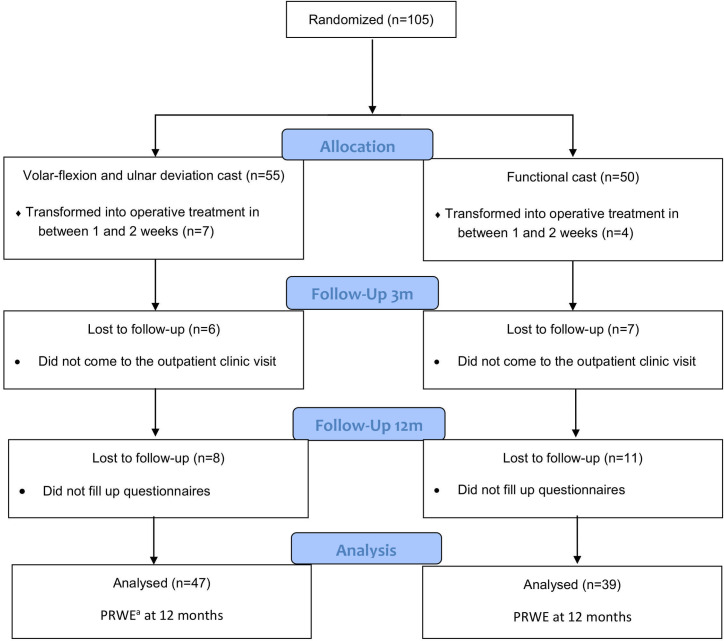
The flow diagram of the study (CONSORT).aPRWE = patient-rated wrist evaluation.